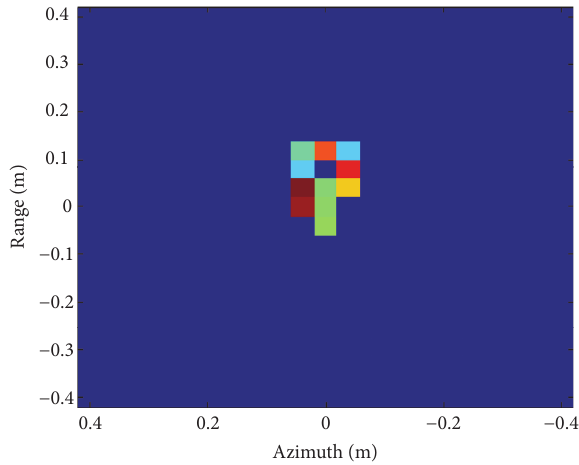
Figure 10: THz-SAR image slice of the vibrating tank model on the Isleta Lake background, refocused by the ExCoV